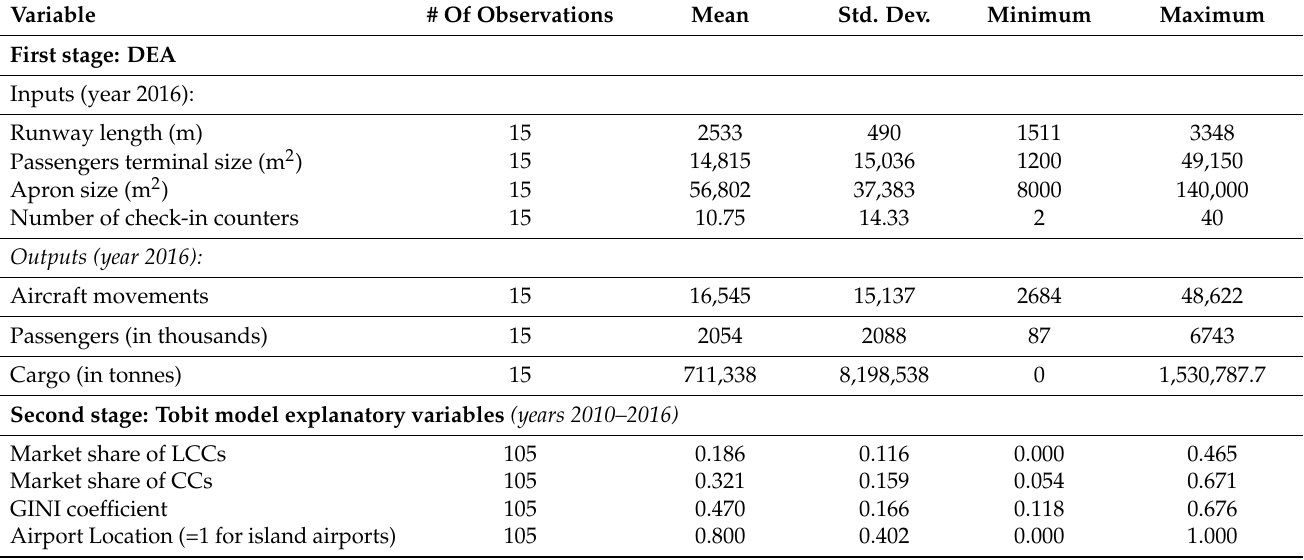
Table 4. Descriptive statistics of the variables used in the first- and second-stage